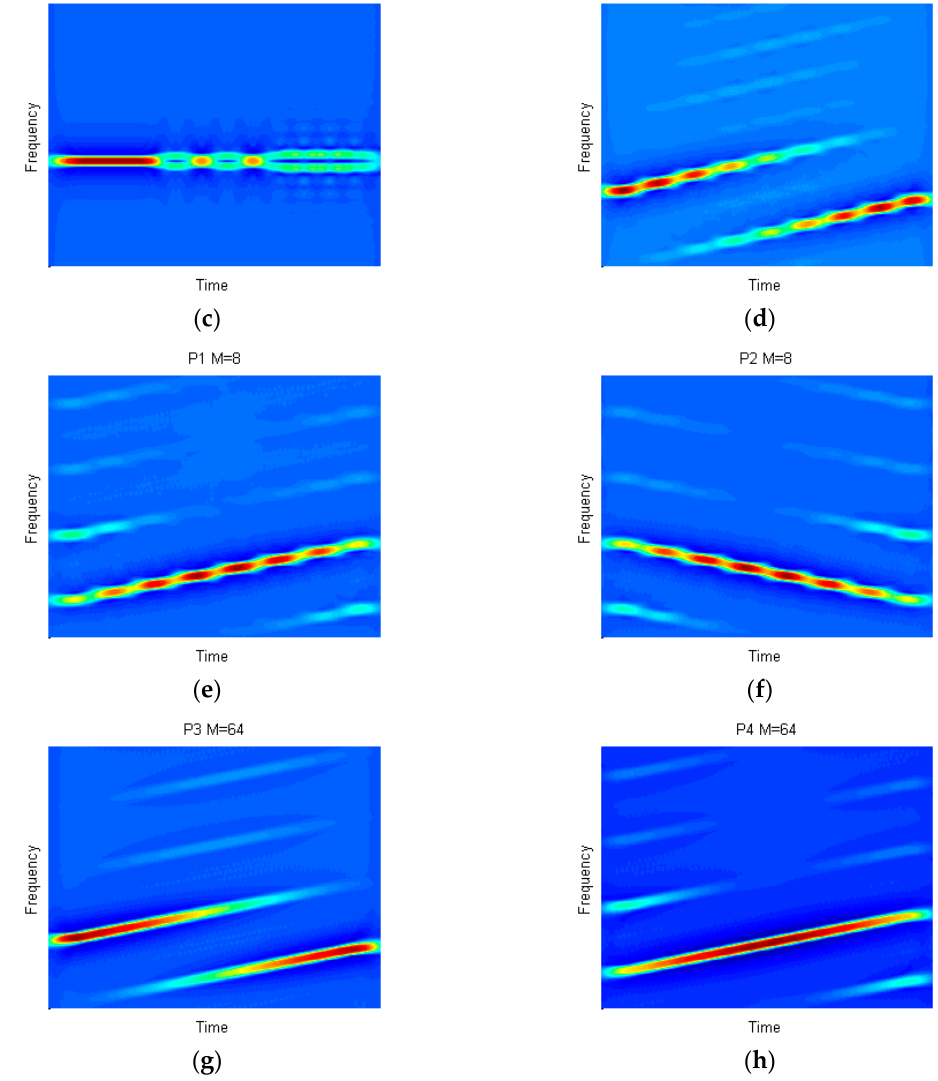
Figure 6. The Choi-Williams distribution (CWD) results of eight waveforms are displayed in this figure.  is set to 1 in this paper. ( a ) CWD image of LFM, ( b ) CWD image of Costas, ( c ) CWD image of BPSK, ( d ) CWD image of Frank, ( e ) CWD image of P1, ( f ) CWD image of P2, ( g ) CWD image of P3, ( h ) CWD image of